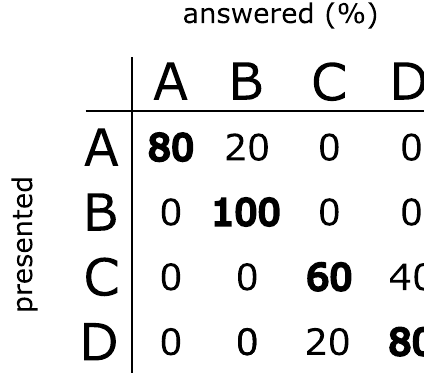
Figure 9. Complex pathway recognition experiment using passive haptics: distribution of answers